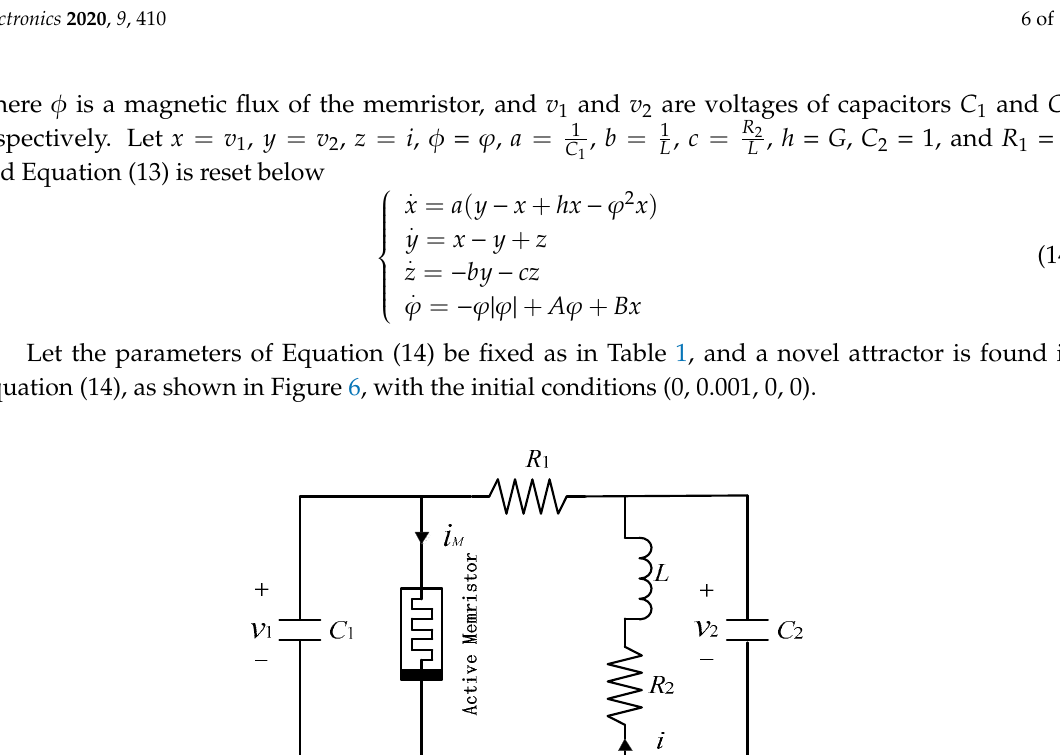
Table 1. Parameter values of typical attractors of the memristor-based chaotic system.